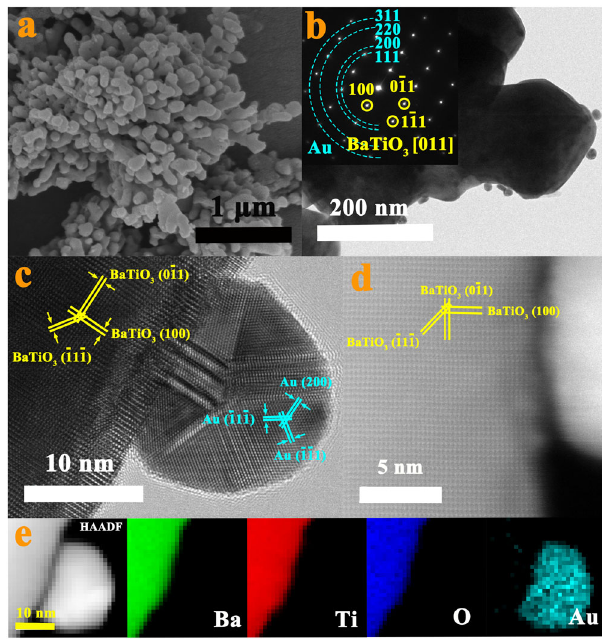
Fig. 2 | Morphology characterizations of Au/BaTiO 3 NPs. a SEM image. b TEM image with SAED pattern as inset. c HRTEM image. d HAADF-STEM image with atomic structure as inset. e HAADF-STEM image and corresponding elemental mapping of Ba, Ti, O, and Au